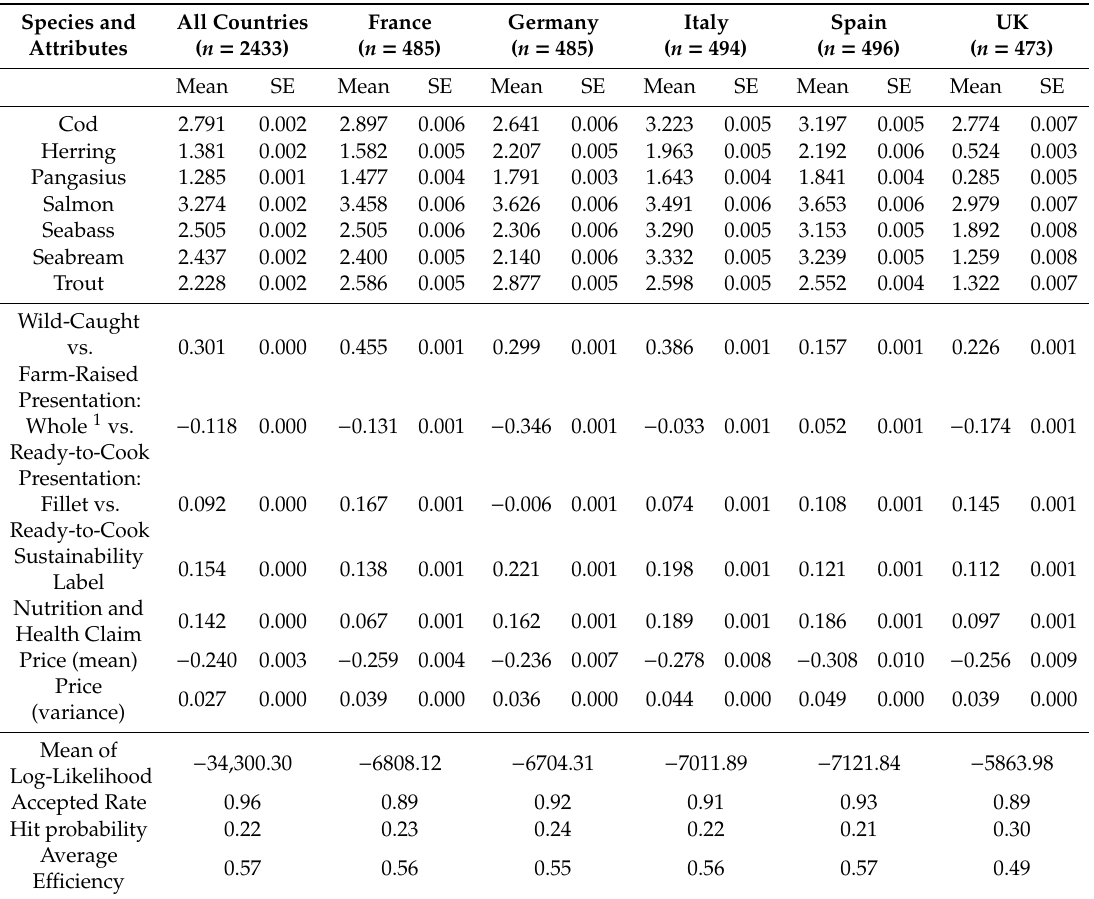
Table 5. β coe ffi cients estimates of Mixed Logit (ML) models (Mean; SE, Monte Carlo standard